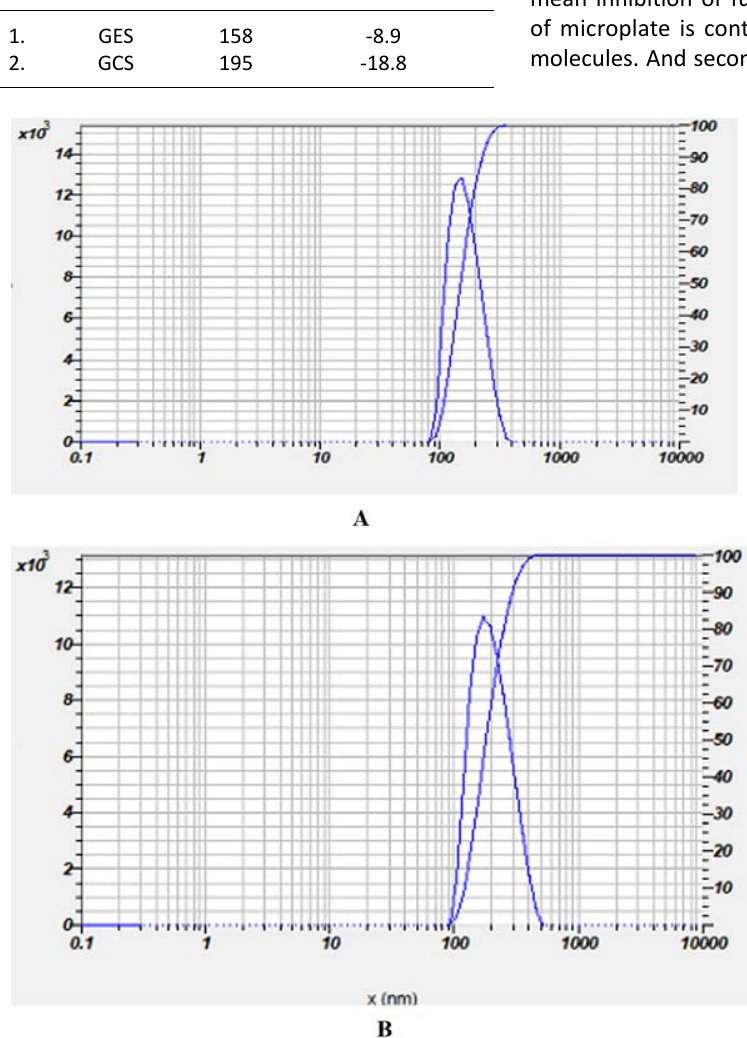
Fig. 5. Size distribution of Nigella sativa silver nanoparticles (A) Ethanolic extract (B) Chloroform extract